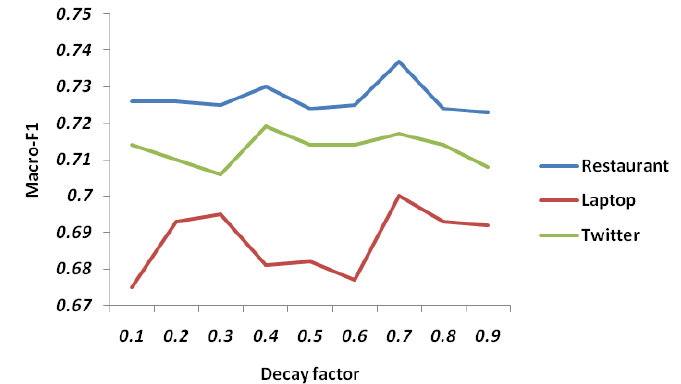
Figure 4. The effect of varying the novelty decay factor on Macro-F1.